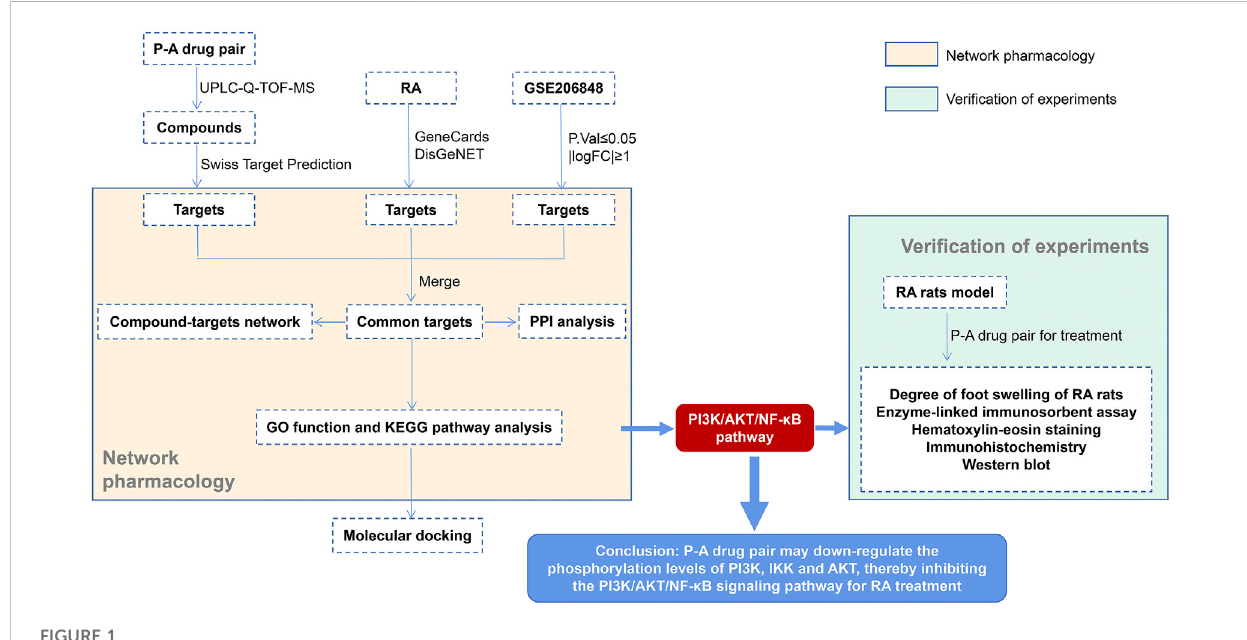
FIGURE 1 Detailed fl owchart of the